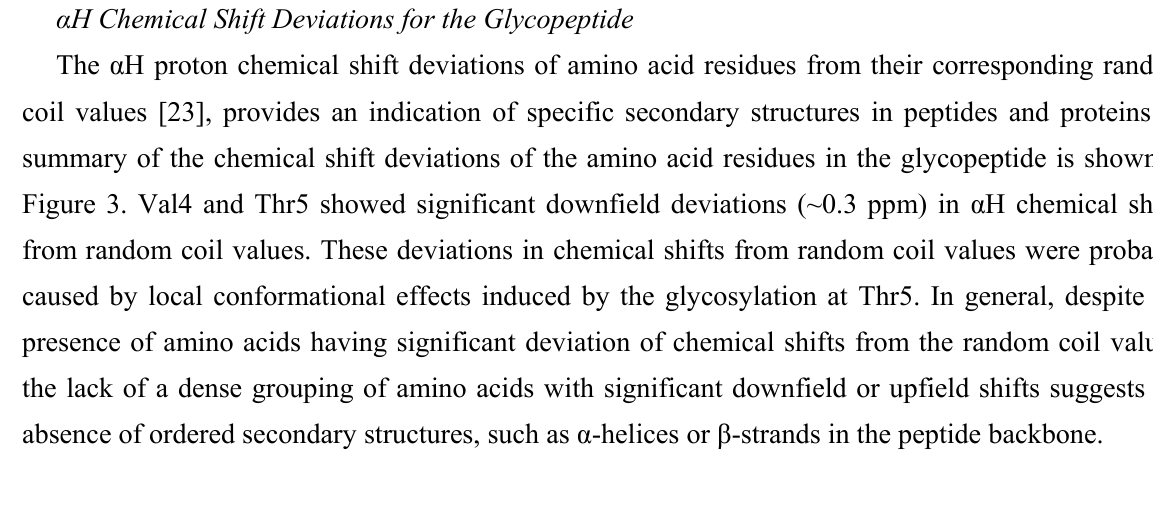
Sugar-peptide NOE Connectivities for the